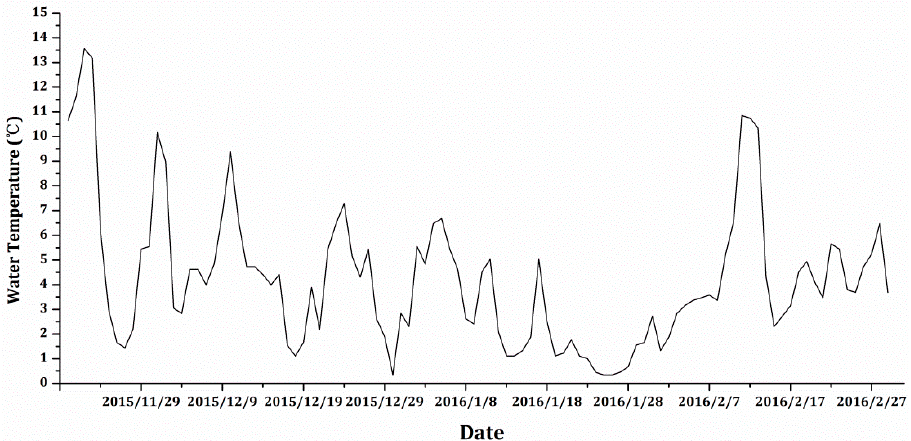
Figure A1. Daily water temperature of the systems during the pre-processing and experimental periods.